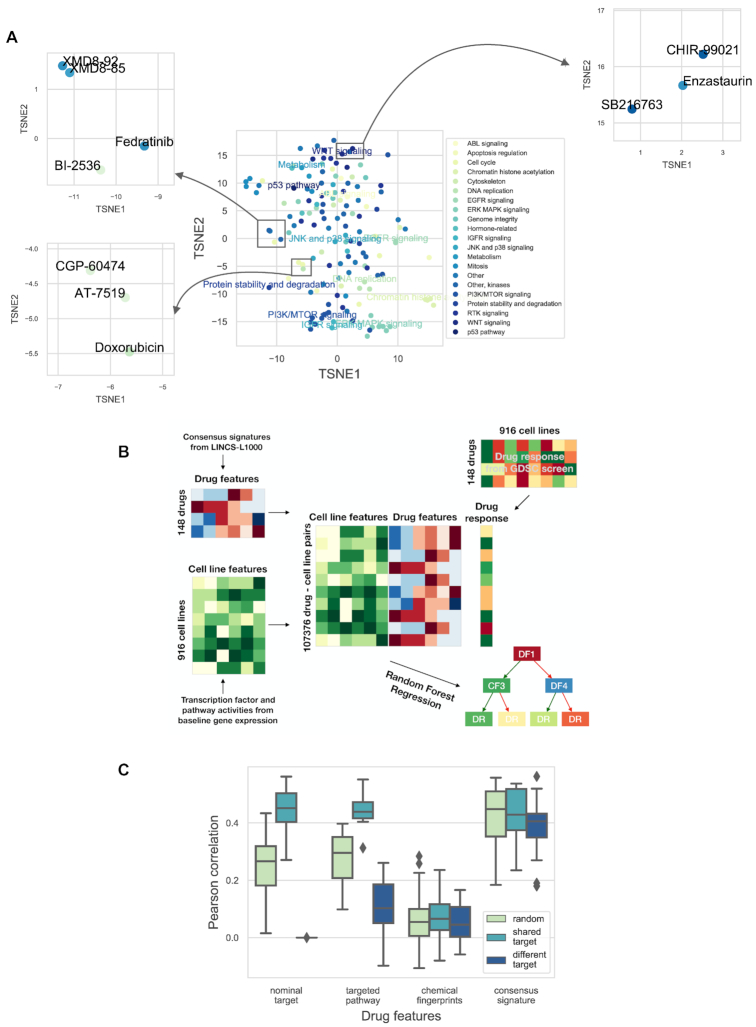
Consensus perturbation signatures for drug sensitivity prediction. (A) t-SNE plot (learning rate 80, perplexity 20, number of iterations 1000) of the consensus signatures of GDSC drugs. Data points (intersection of GDSC and LINCS-L1000 drugs, 148 drugs) are colored based on targeted pathway. For selected clusters, the targeted pathway is also text labeled. Inserts: selected clusters of drugs with different pathway annotations. (B) A schematic representation of the machine learning pipeline. Cell line specific (tissue type, pathway and transcription factor activity) and drug specific (nominal target, targeted pathway, chemical structure based Extended-Connectivity Fingerprints and consensus signature) feature matrices were created for the cell lines and drugs of the GDSC study. Features were concatenated for each drug–cell line pair where drug response was available in the GDSC screen and this feature matrix was used to train the Random Forest Regression models. (C) The results of the machine learning models for drug response AUC predictions. The data were split into training and test sets based on drugs (50–50% percent). Splitting was performed three different ways (color coded): randomly, with the constraint that for each drug in the test set there was a drug with the same nominal target in the training set (shared target), or with the constraint that for each drug in the test set there was no other drug with shared nominal targets in the training set (different target). Different drug specific features (x axis) were used by the models. Cell wise average Pearson correlation values are shown as boxplots for the different drug specific features/splitting strategies (results from 20 random subsampling validation).